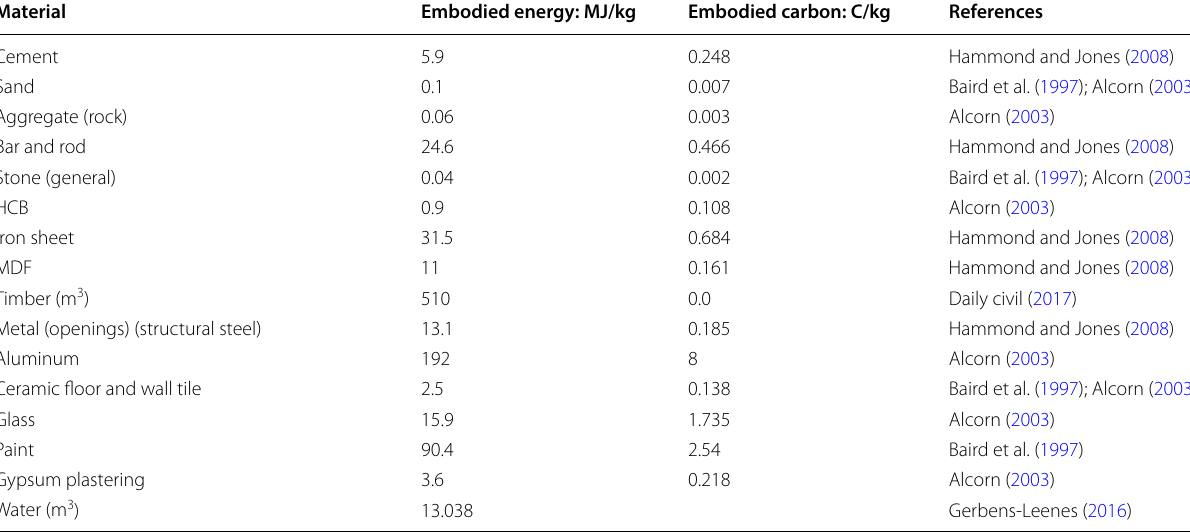
Table 7 Embodied energy and carbon of construction